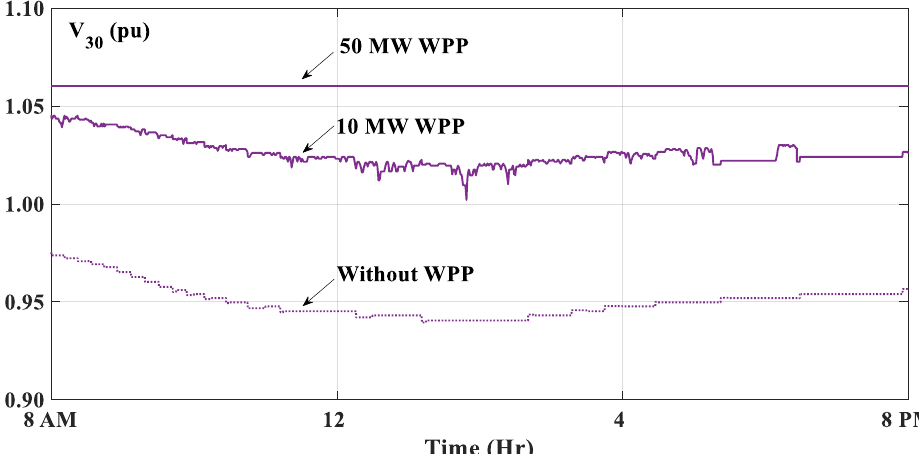
Figure 13. Voltage profiles at PCC for a WPP with reactive power compensation capability, the WPP is connected at the node “30” of the IEEE 30-node.